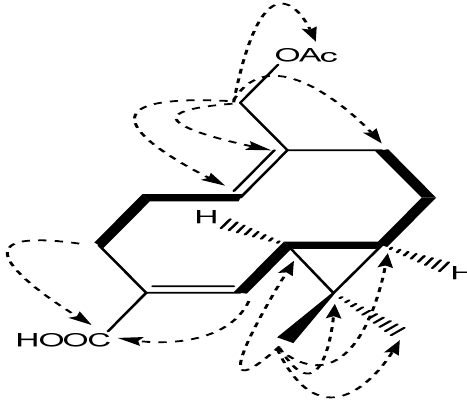
Figure 2. The correlations of structures, 1 H- 1 H COSY and Key HMBC of 2